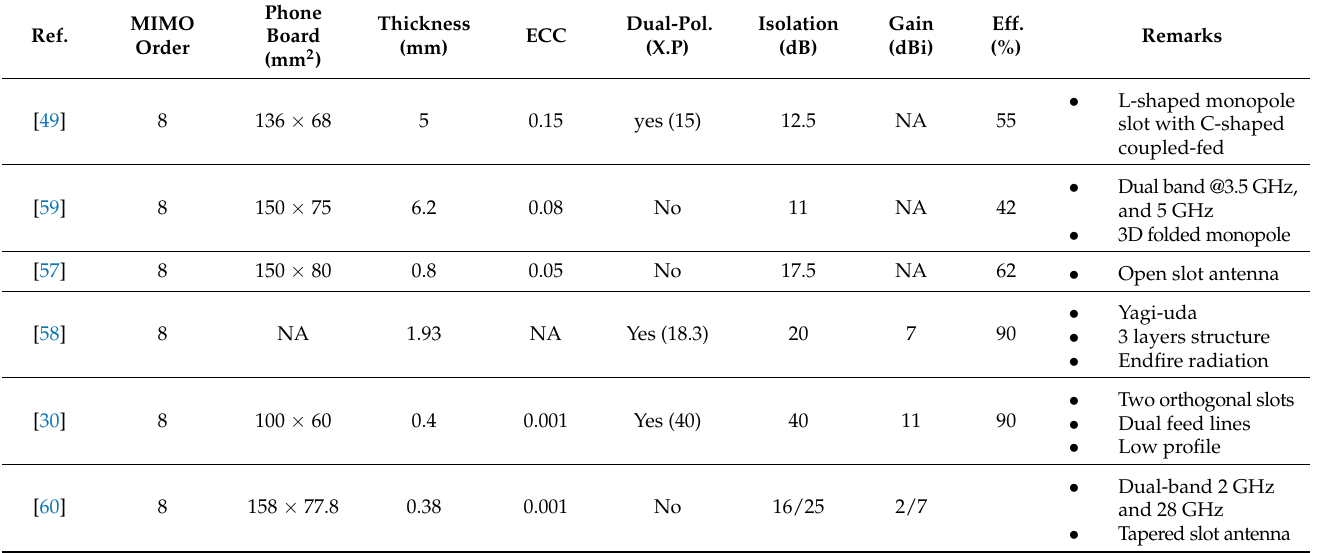
Table 3. MIMO antenna for 5G